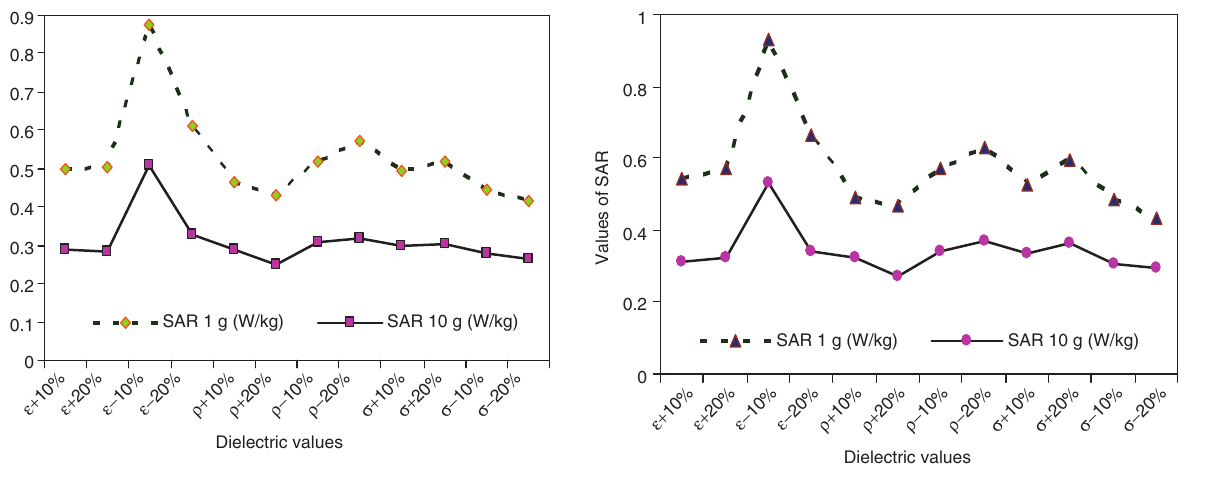
Figure 3 Deviation of the peak of unaveraged SAR in different dielectric properties of FR4 substrate at 1800 MHz.